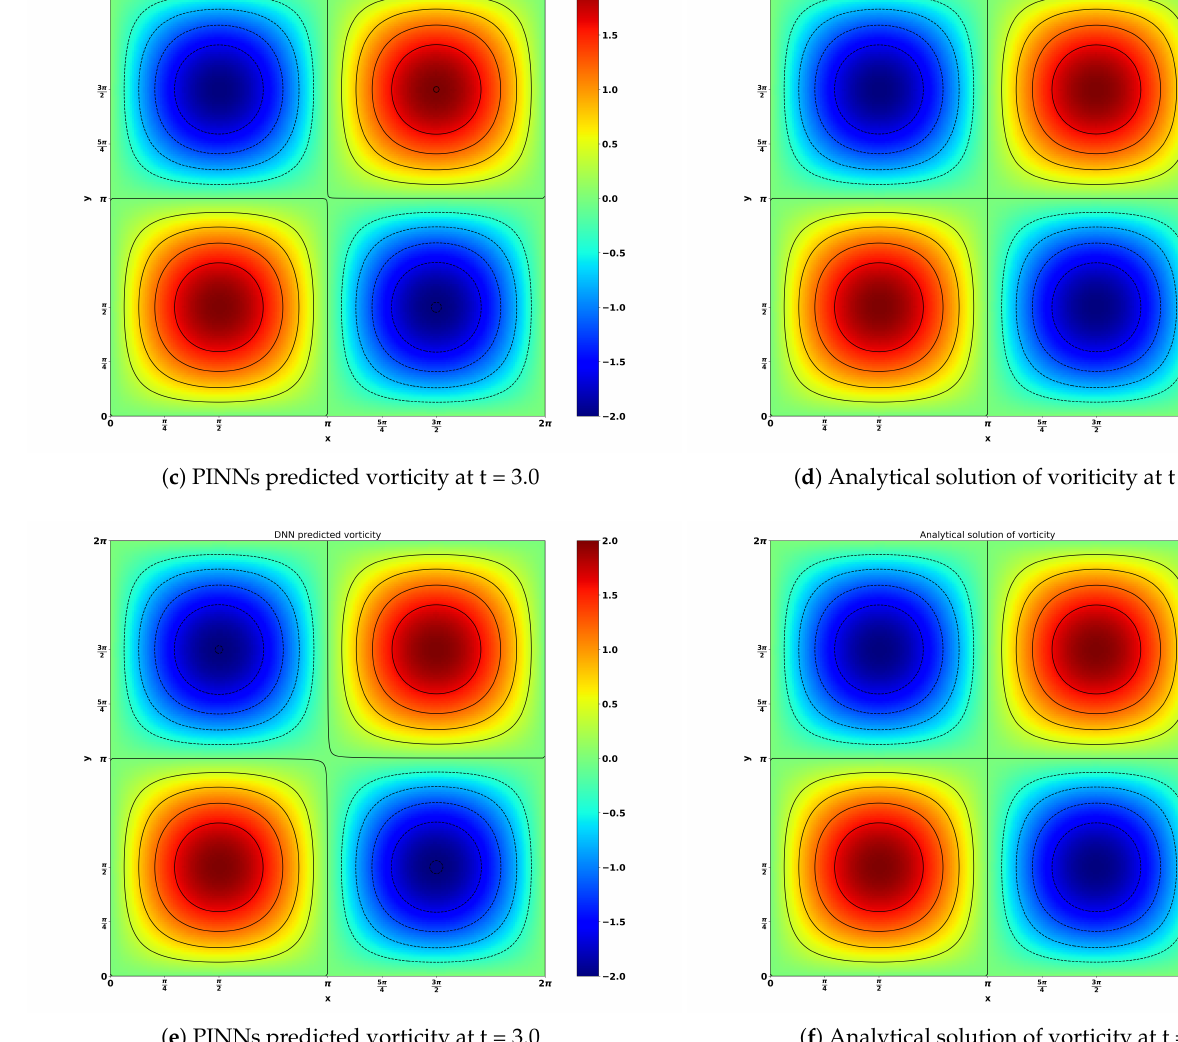
Figure 11. Predicted vorticity from PINNs ( left ) and analytical results ( right